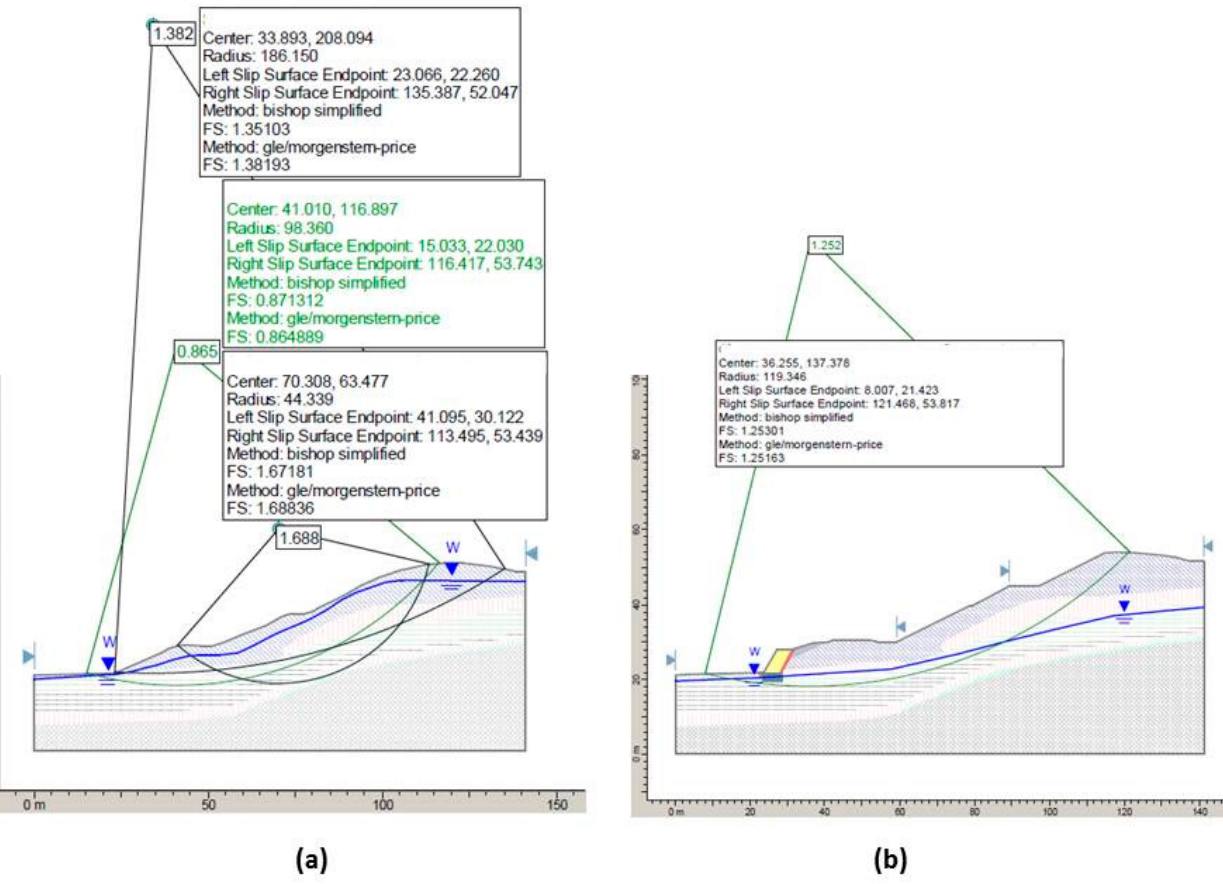
Figure 9. Safety factor analyses of profile I-I ′ (see Figure 2): ( a ) slope in its natural state after the parking excavation; ( b ) slope state after implementing the stabilization measures.